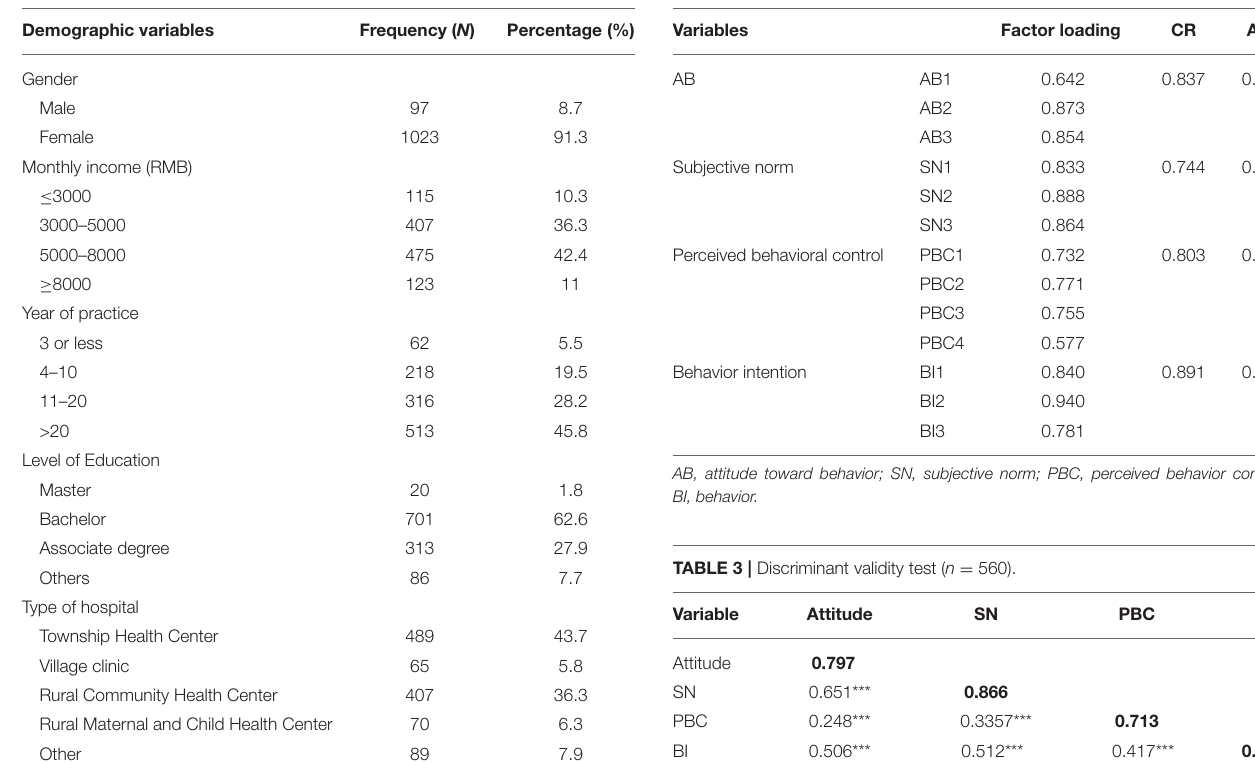
TABLE 1 | Demographics and relevant characteristics of participants ( n =1120). TABLE 2 | Convergent validity test ( n = 560).